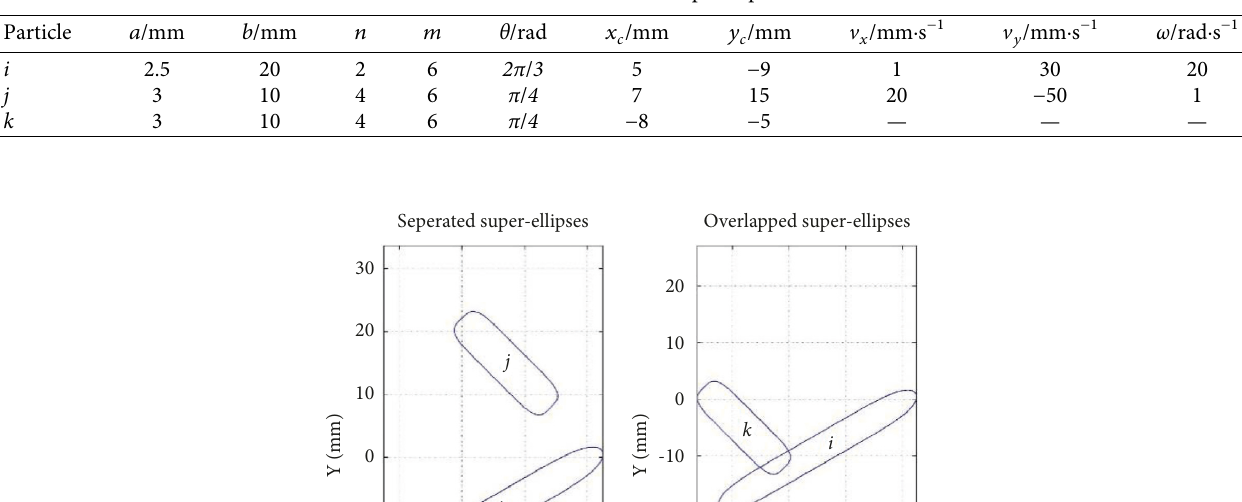
Figure 1: Superellipses of various equipotential surfaces. Table 1: Parameters of superellipses.